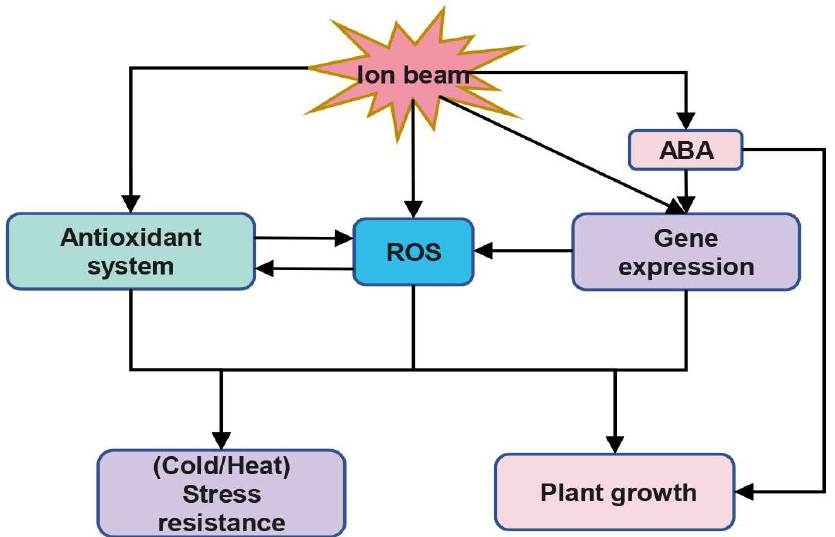
Figure 2. A simple mechanism for plant response to ion beam. ROS, reactive oxygen species; ABA, abscisic acid.